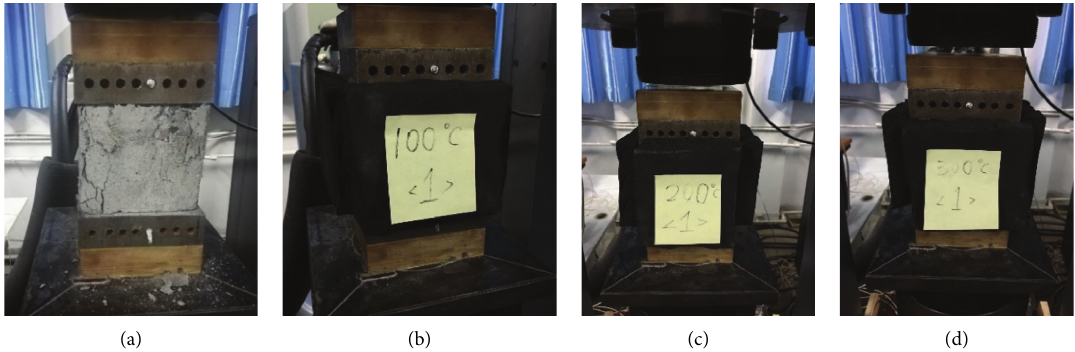
Figure 11: The uniaxial compression test with copper heating plates: (a) room temperature; (b) 100 ° C; (c) 200 ° C; (d) 300 °